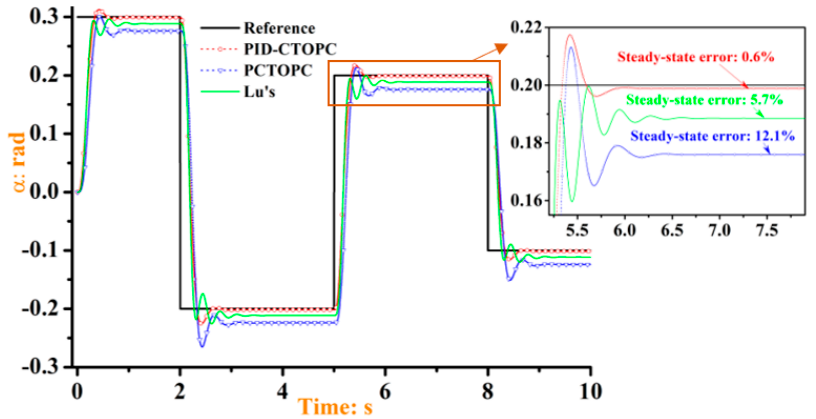
Figure 2. Group 1 with constant disturbance: Attack angle α .